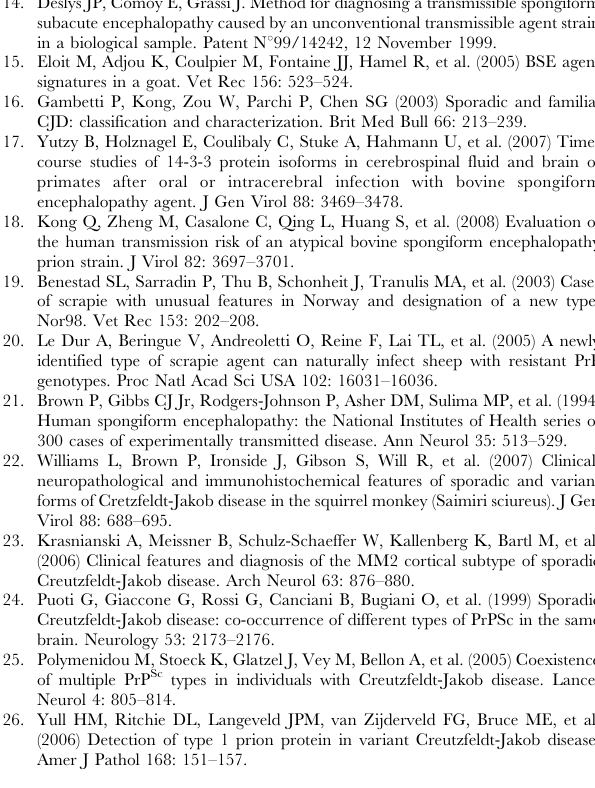
Figure S2 Lesion profiles in cBSE- and BASE-infected ma- caque, and in MM2 sporadic CJD patients. The lesions were scored from 0 to 4 (negative, light, mild, moderate, and severe)